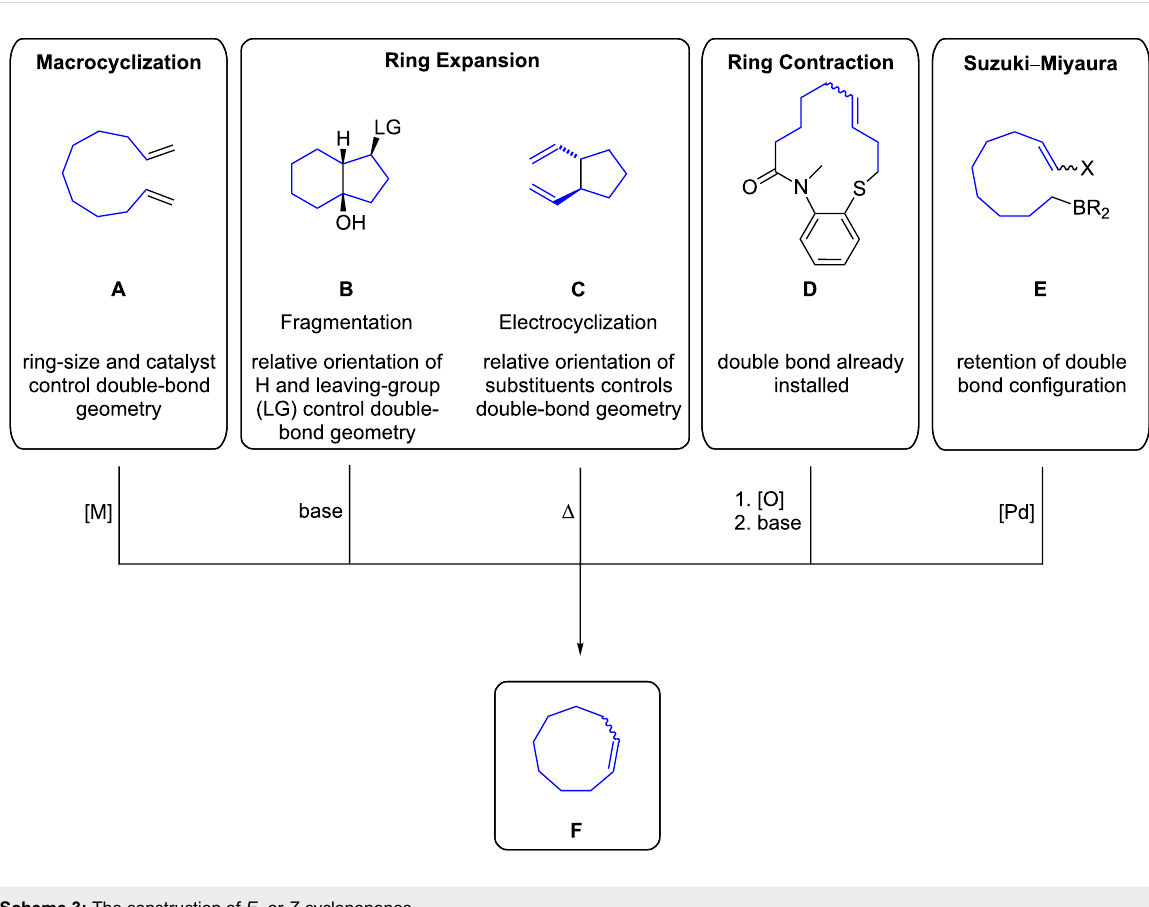
Scheme 3: The construction of E- or Z- cyclononenes.